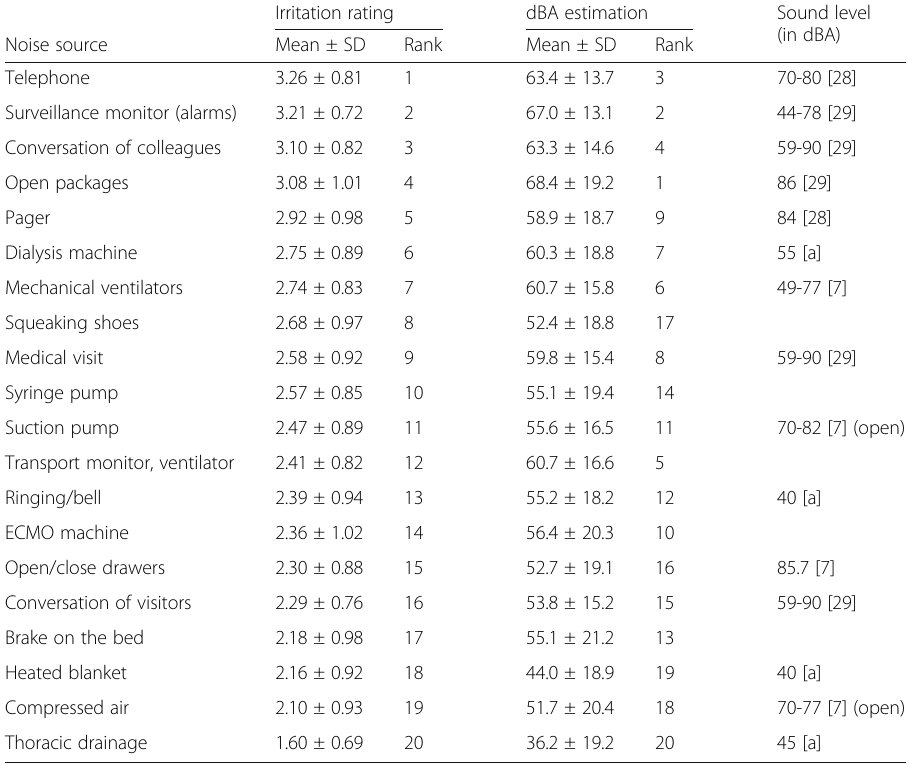
Table 1 Irritation ratings and sound level estimations of 20 noise sources per category Irritation